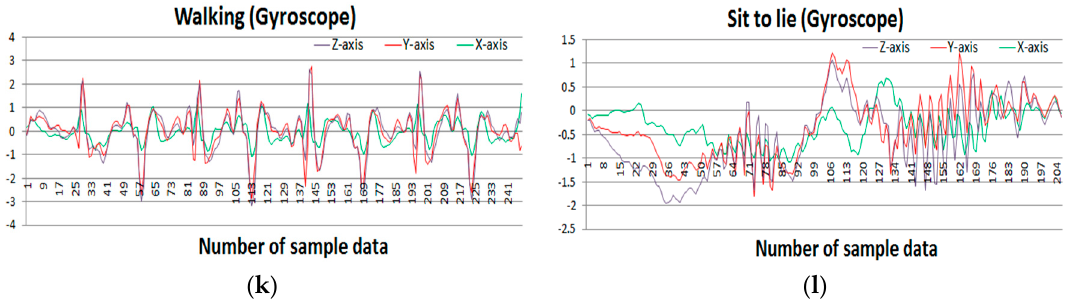
Figure 7. Sample accelerometer data ( a , c , e , g , i , k ) and gyroscope data ( b , d , f , h , j , l ) for different activities: ( a , c ) Stand to sit activity, ( e , g ) sitting activity, ( i , k ) walking activity, ( b , d ) stand to lie, ( f , h ) laying activity, ( j , l ) sit to lie activity.